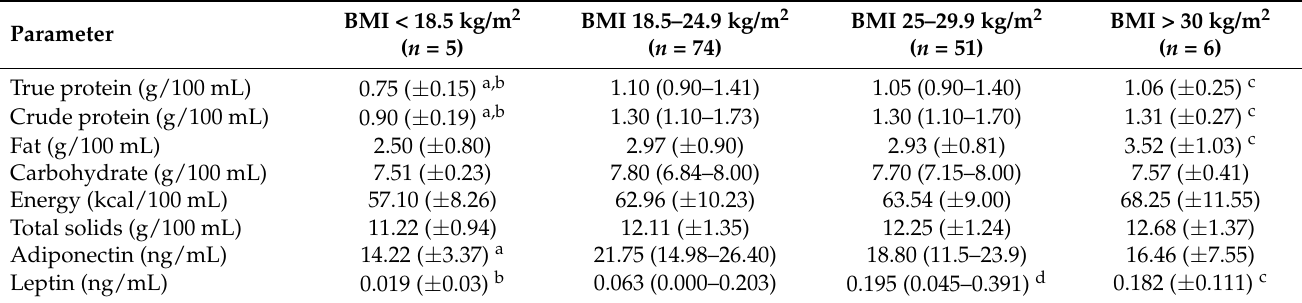
Table 4 highlights the HM composition among the different maternal BMI categories. Table 4. Human milk nutrient composition compared in different maternal BMI categories.